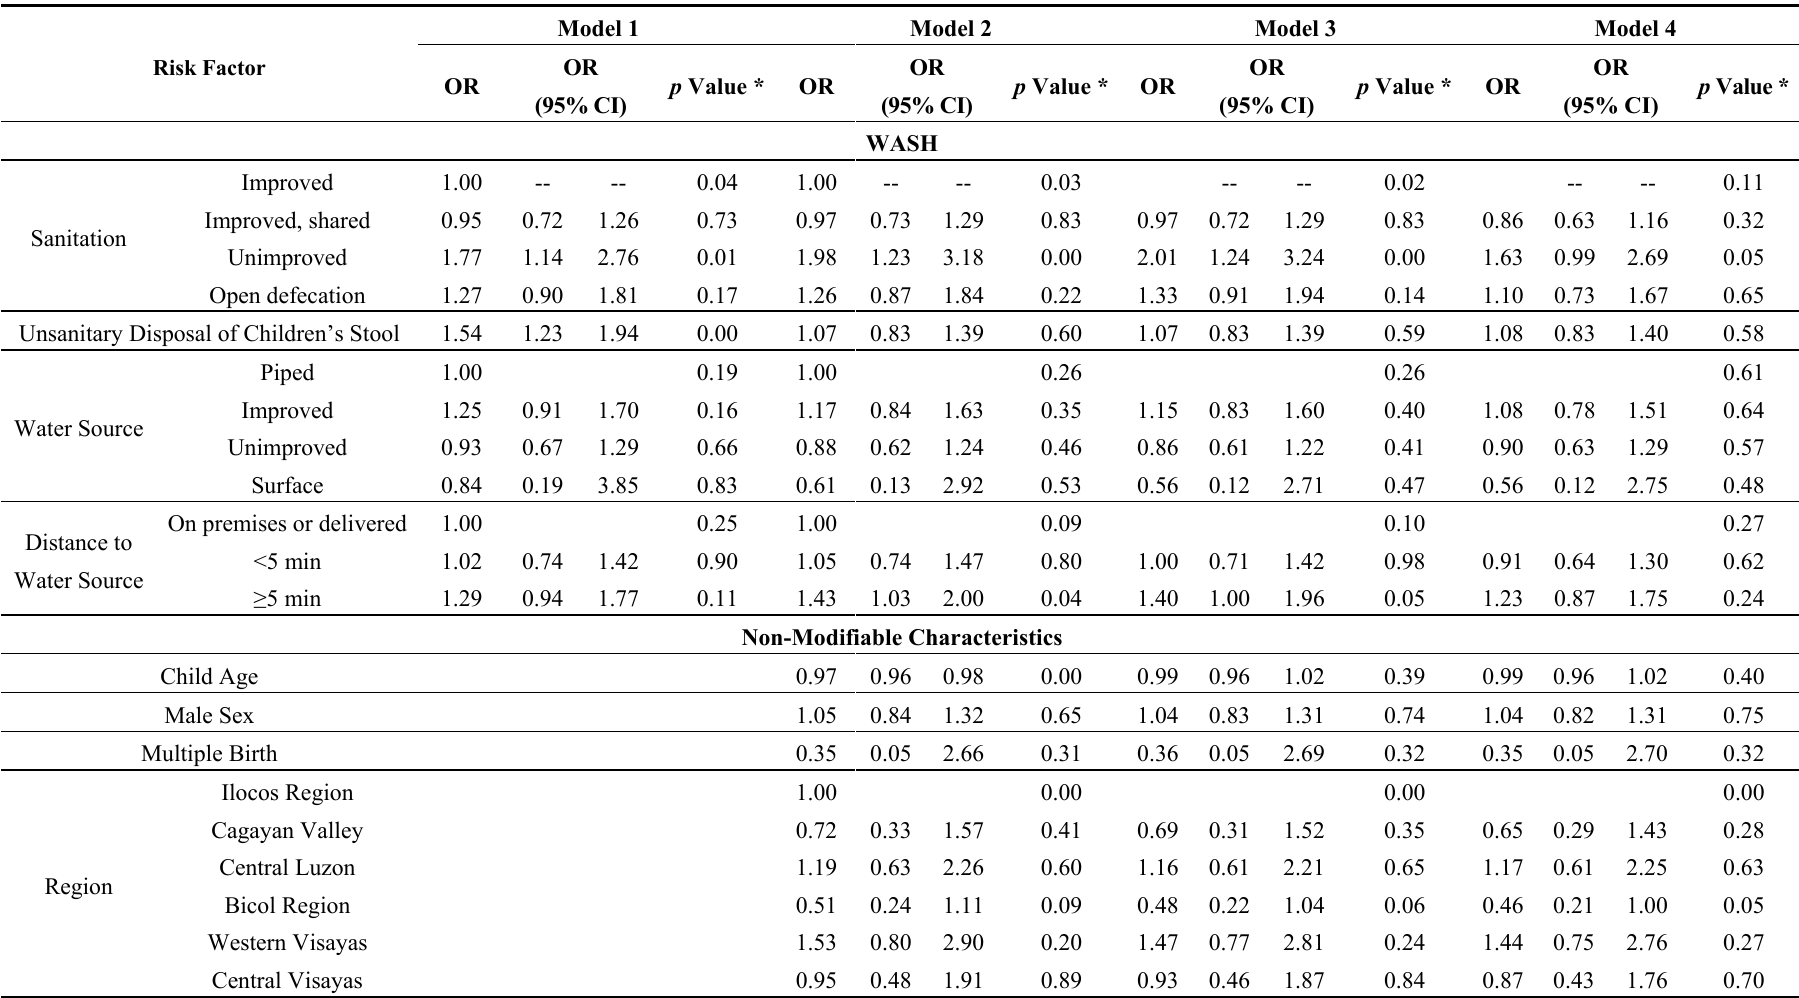
Table 2. Effect of WASH complex and other risk factors on childhood diarrhoea: WASH complex (Model 1) and adjustments for non-modifiable factors (Model 2), susceptibility (Model 3) and socioeconomic characteristics (Model